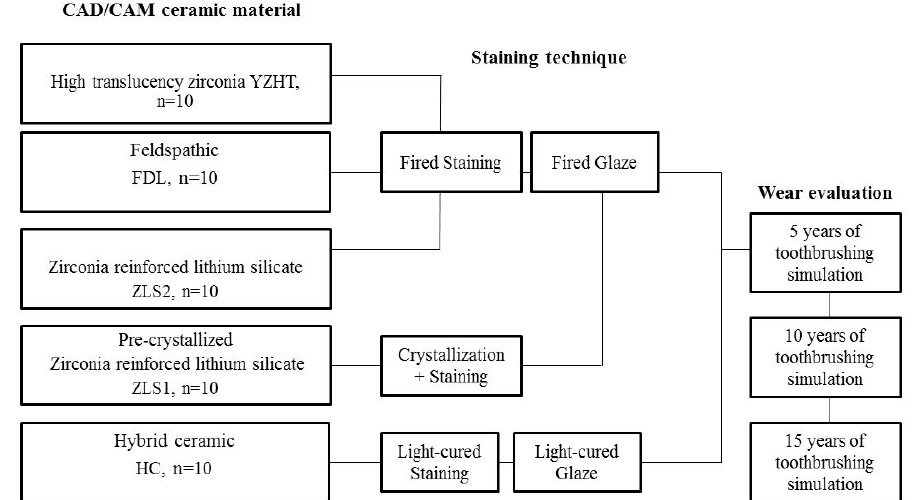
CAD/CAM ceramics submitted to staining procedures prior to the toothbrushing simulation.